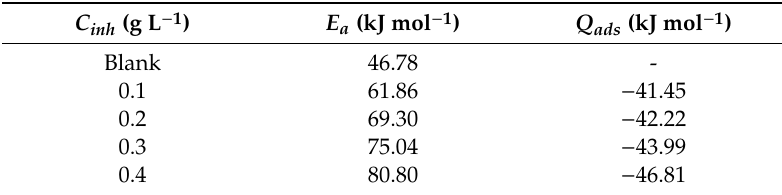
Table 4. Apparent activation energies ( E a ) and heat of adsorption ( Q ads ) calculated in the temperature range of 25–45 ◦